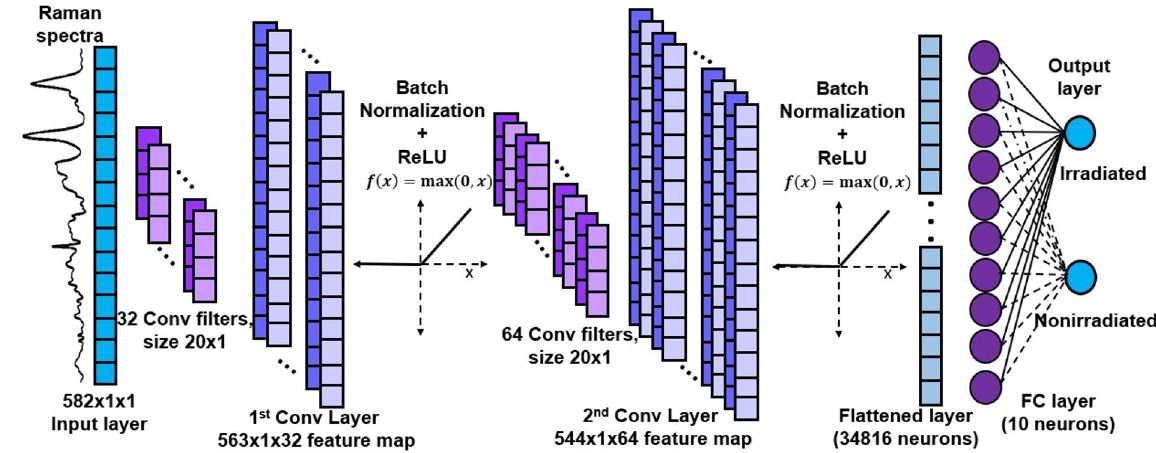
Figure 1. CNN architecture for Raman spectroscopy